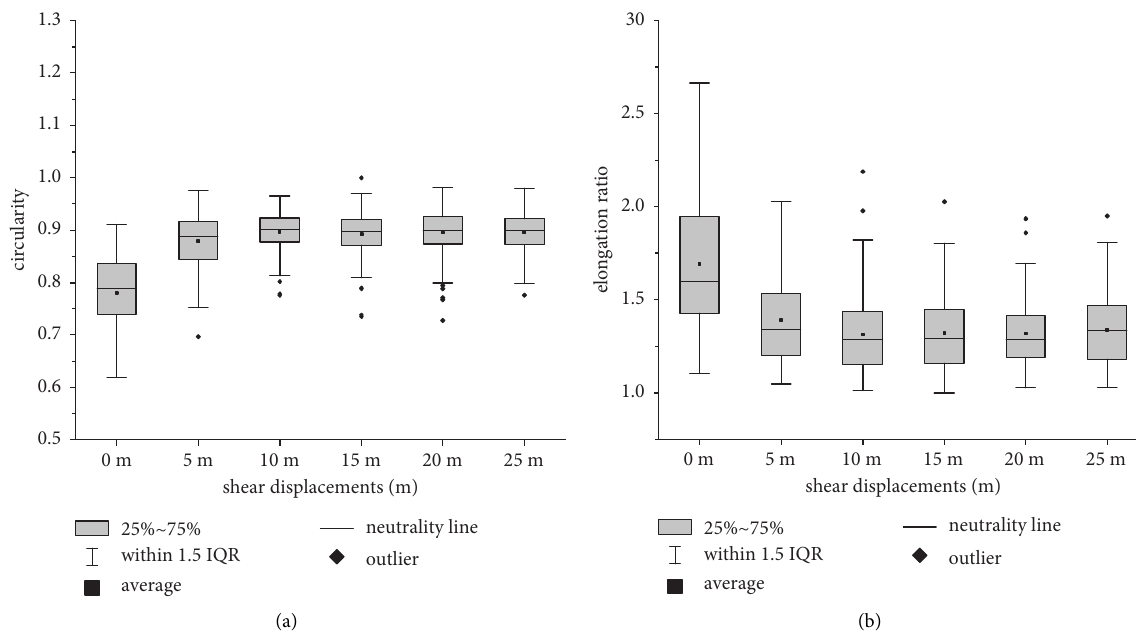
Figure 9: Box plot of circularity variation and elongation change of samples under shear. (a) Circularity of quartz sand after shearing at 0m, 5m, 10 m, 15m, 20 m, and 25m. (b) Elongation of quartz sand after shearing at 0m, 5m, 10m, 15m, 20m, and